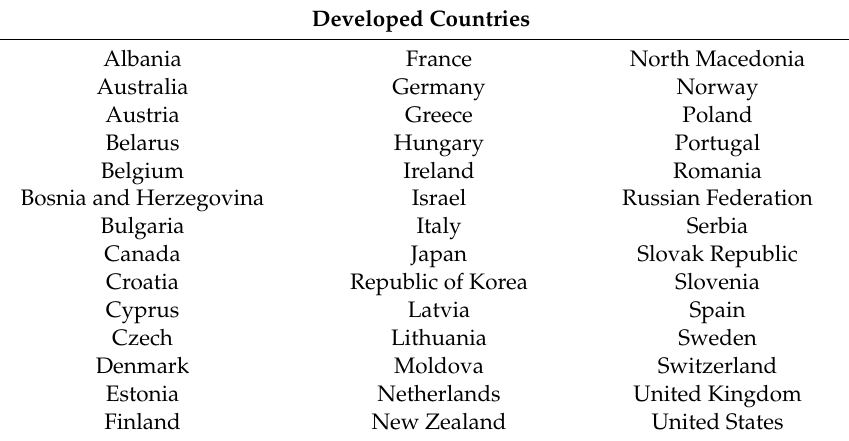
Table 3. List of 42 developed countries.